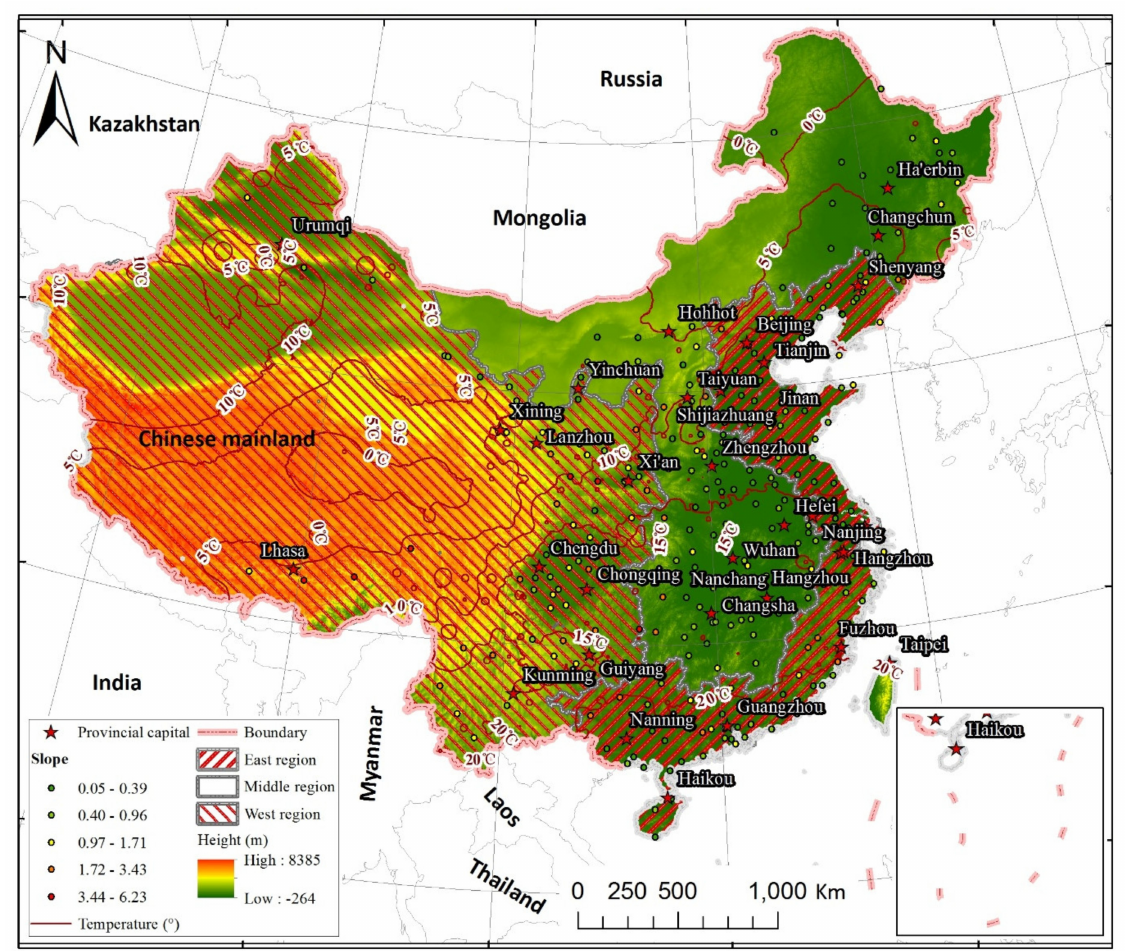
Figure 1. The annual average temperature, elevation, and cities in